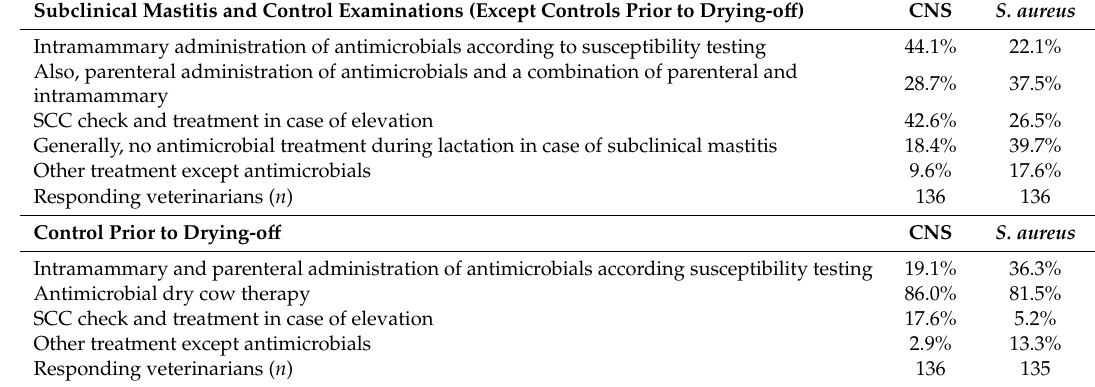
Table 5. Staphylococcal mastitis—Treatment approaches of veterinarians in Austria in response to culture results (multiple answers